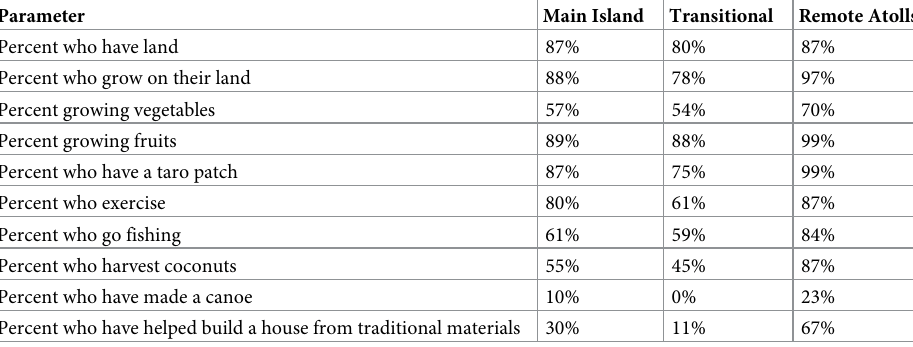
Table 4. Agriculture and physical activity in the Pohnpeian study populations.